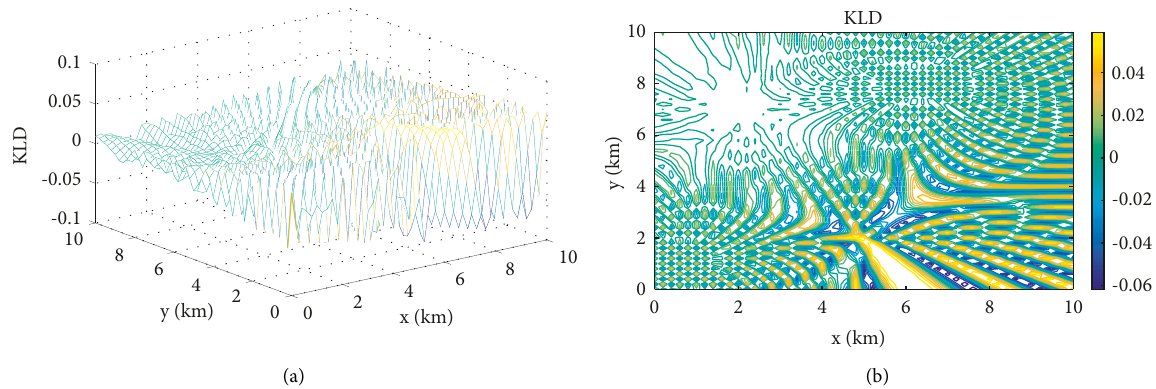
Figure 11: The simulation results when a target appears at Position A . (a) The 3D KLD information distance distribution. (b) The 2D KLD information distance